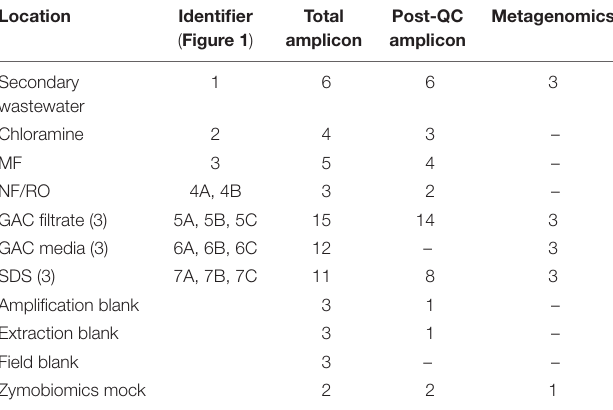
Frontiers in Microbiology |